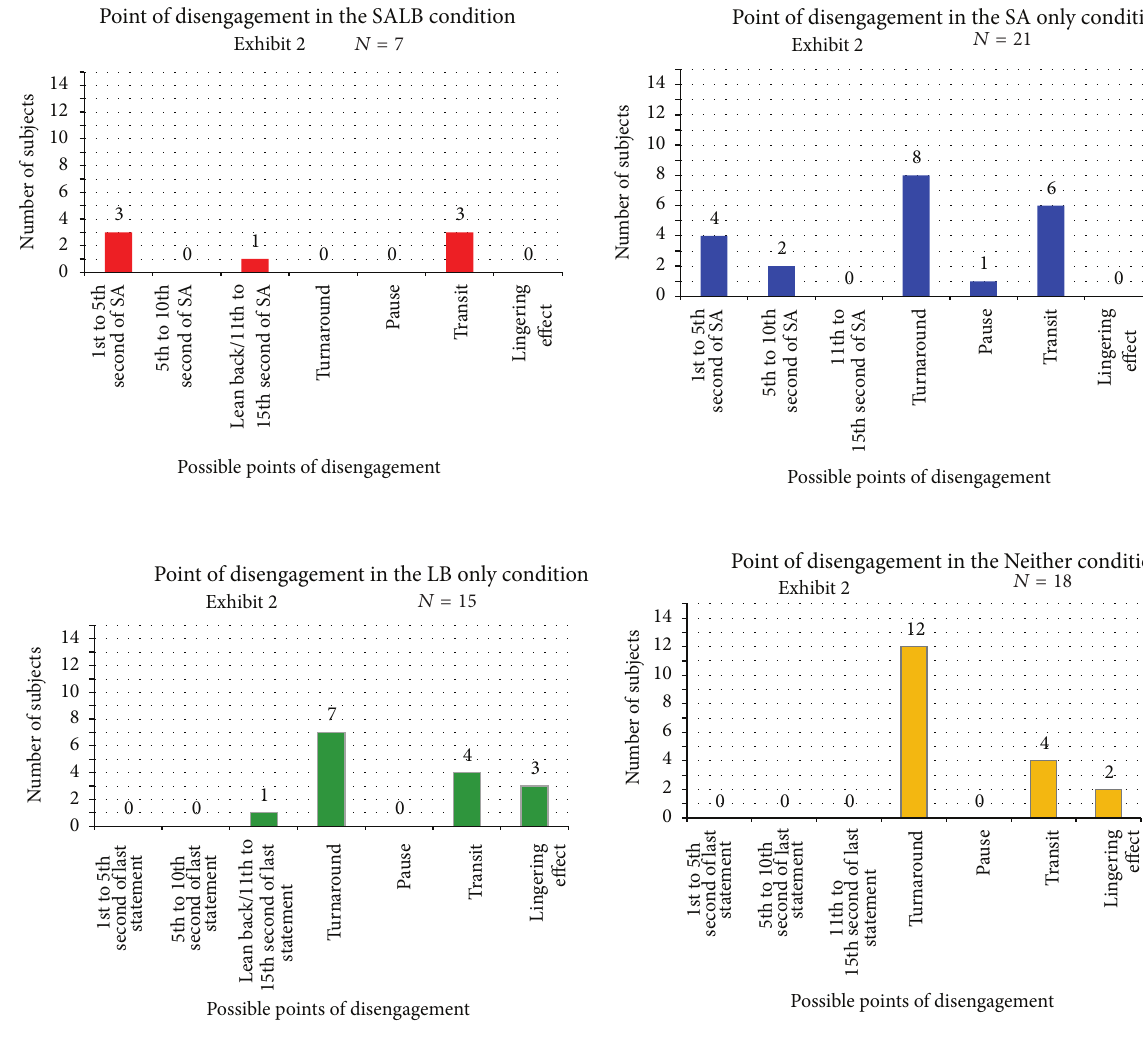
Figure 11: Points of disengagement in the four conditions at exhibit 2.